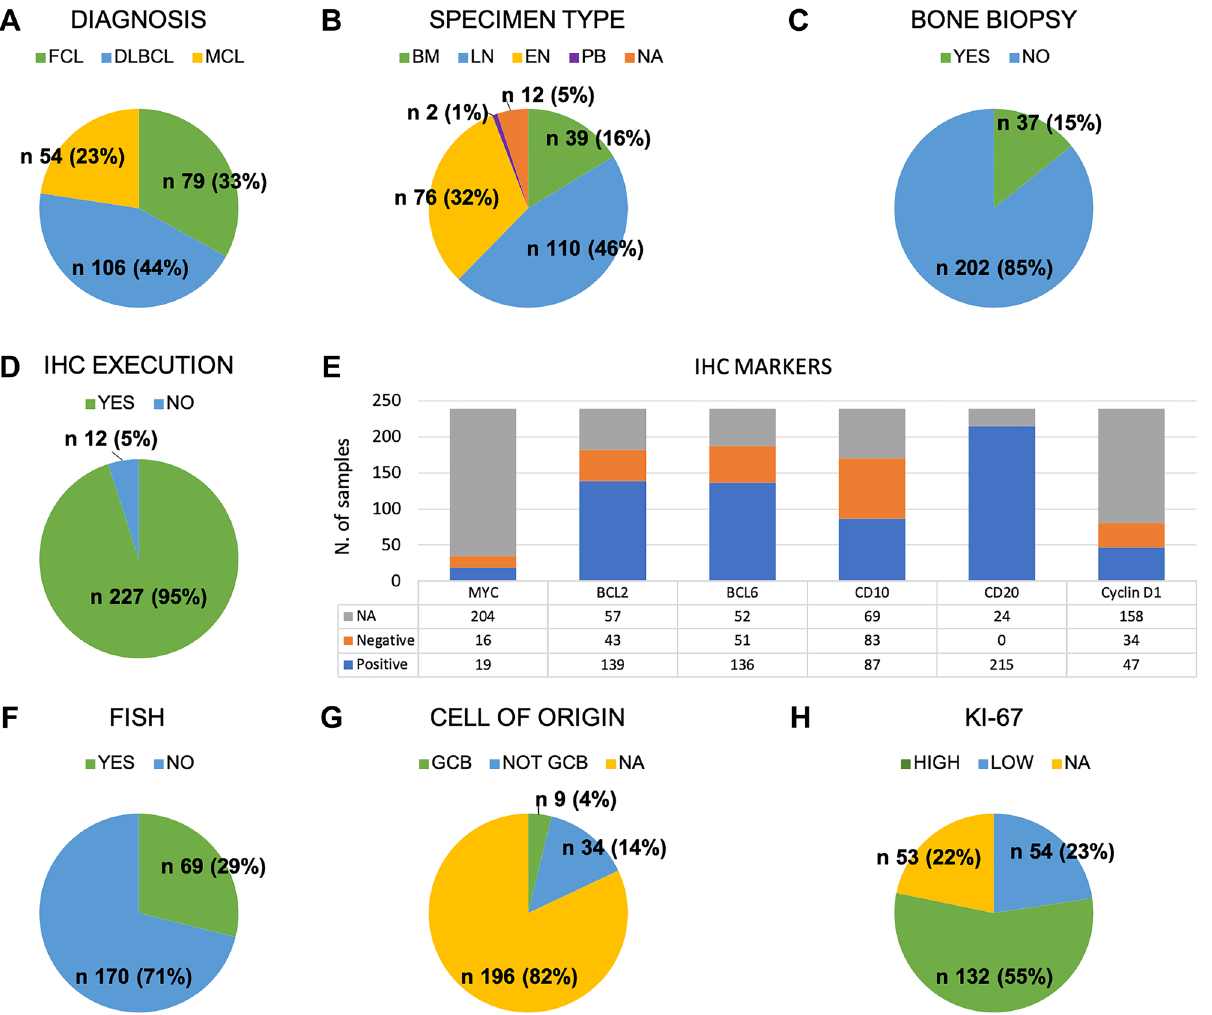
Figure 2. Characteristics of data retrieved from diagnostic reports. Graphical representation of diagnostic features, subdivided into specific fields, captured by ARGO from a total of n. 239 paper-based pathology reports of the internal series. Abbreviations. ARGO: Automatic Record Generator for Onco-hematology, FCL: Follicular Lymphoma, DLBCL: Diffuse Large B-cell Lymphoma, MCL: Mantle Cell Lymphoma, BM: Bone Marrow, LN: Lymph-Node, EN: Extra-Nodal, PB: Peripheral Blood, NA: Not Available, IHC: Immunohistochemistry, N: number, CD: Cluster of Differentiation, FISH: Fluorescent in situ hybridization, GCB: Germinal Center